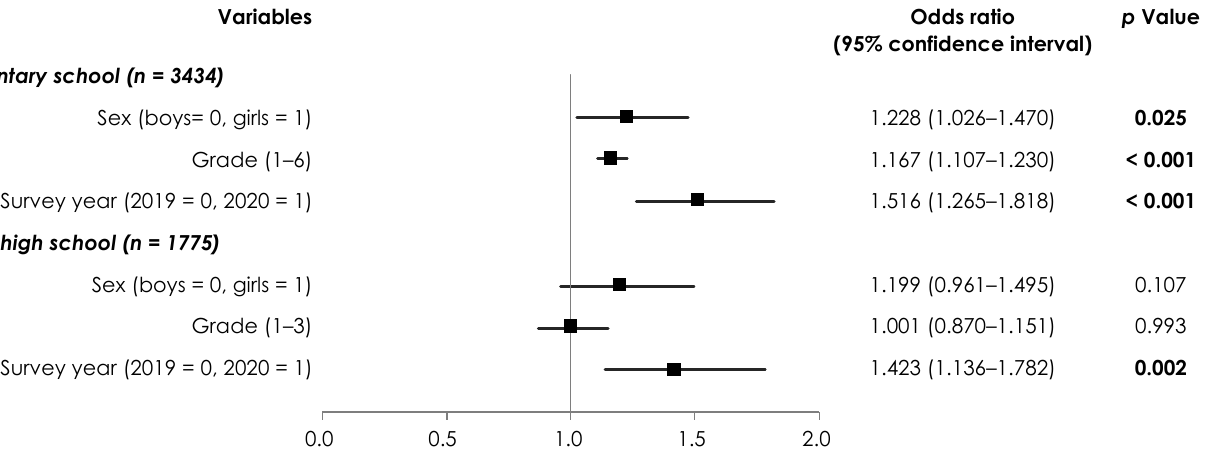
Figure 3. Relationship between the survey year and the left-right difference in eyesight. The depen- dent variable was the left-right difference in eyesight (0 = same, 1 = different), and the independent variable was the survey year. Measures of associations are displayed as odds ratios (black squares) and 95% confidence intervals (horizontal spikes). Significant p -values are shown in